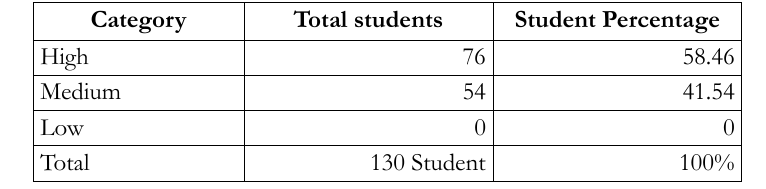
Table 16. Data on the calculation results of the N-GAIN